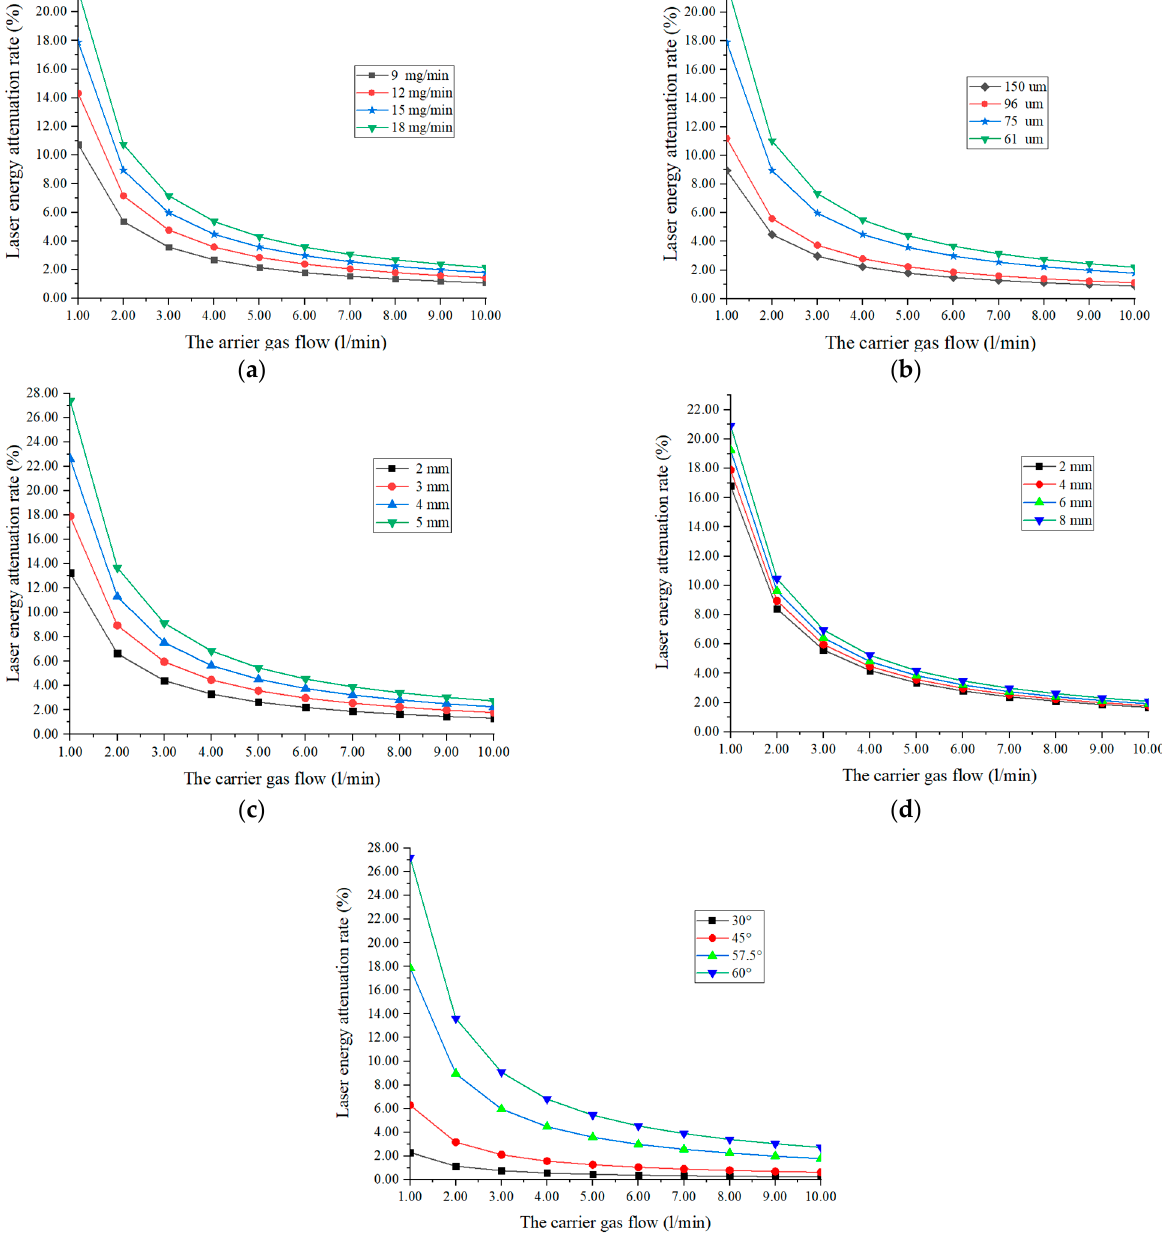
Figure 2. Curve of influence factors of laser energy attenuation rate: ( a ) The powder feeding speed 𝑀 (cid:3043) , ( b ) The powder particle diameter 𝑟 (cid:3043) , ( c ) Nozzle exit radius 𝑟 (cid:3039) , ( d ) Powder nozzle-to-center dis- tance 𝐿 , ( e ) The angle between the x -axis and the nozzle center α . Table 2. The selection of each parameter of the numerical